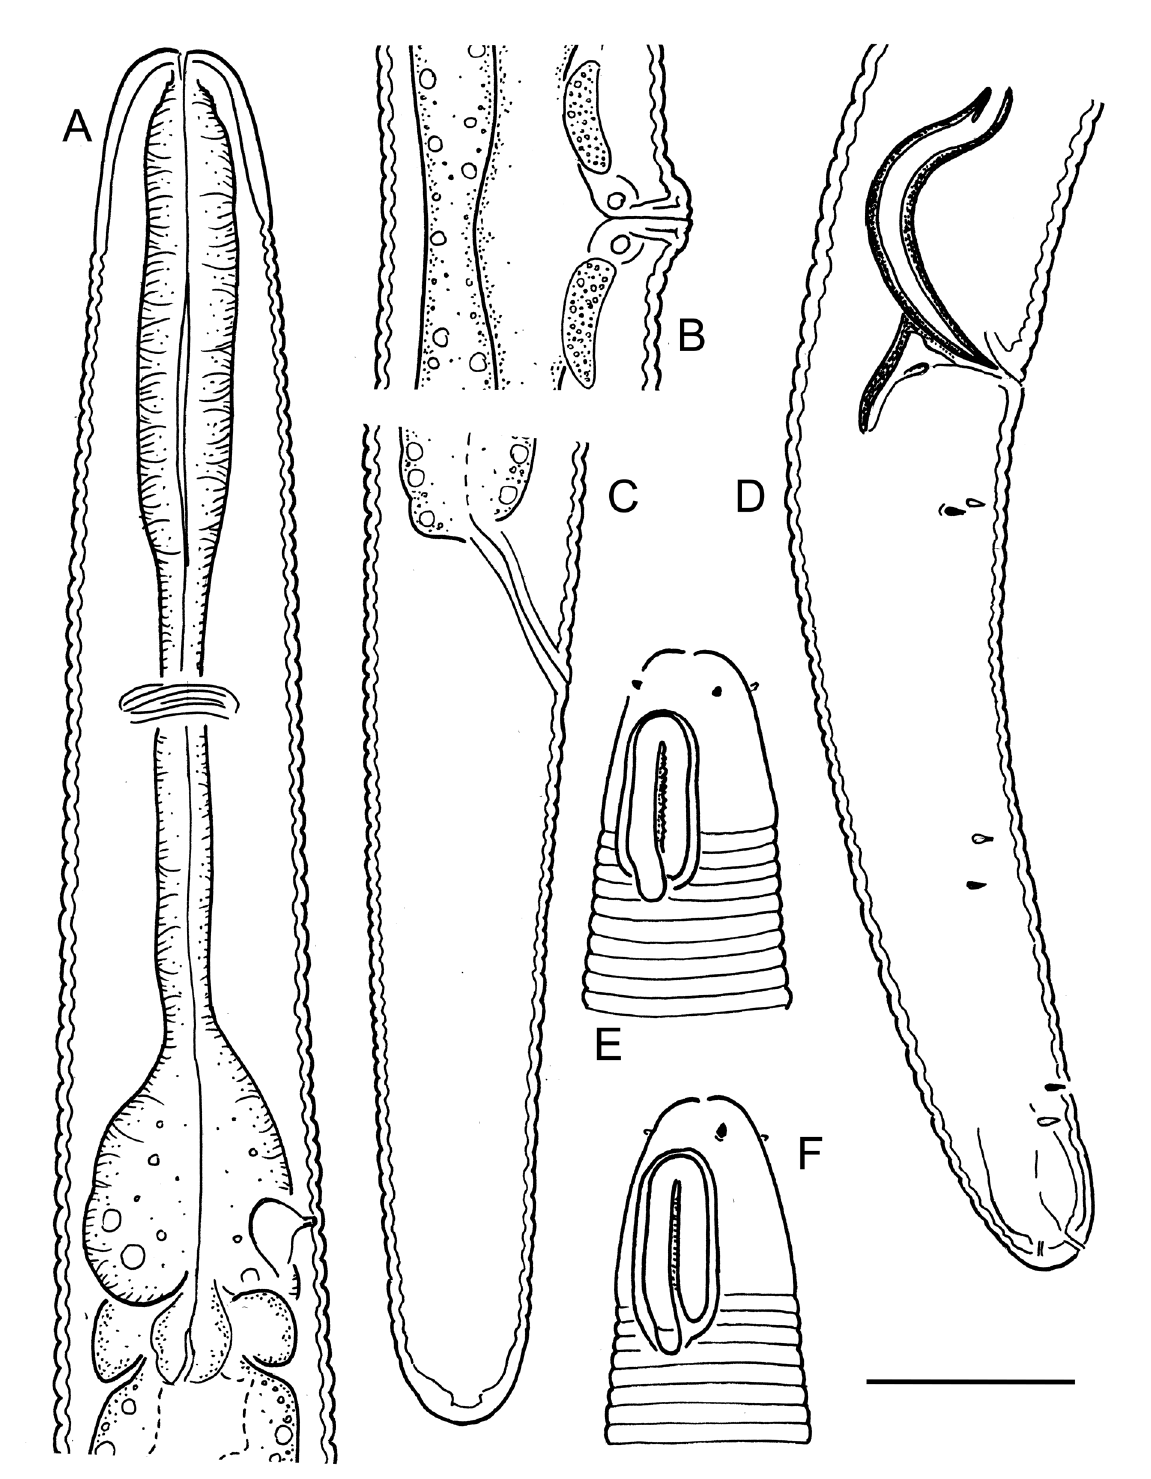
Fig. 7. Diplopeltoides nudus (Gerlach, 1956). A . Female pharyngeal region, optical median section. B . Vulval region. C . Female tail. D . Male tail. E . Female anterior end, surface view. F . Male anterior end, surface view. Scale bar = 20